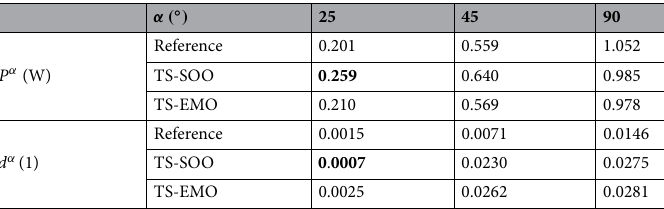
Table 1. Optimization results regarding color point deviation d α , and power P α of algorithm 1, and TS-EMO for α = 25 ◦ , and after local refinement. The designs featuring a multi-layer thin film are compared with the reference design, where only a color point optimization is conducted. In addition to the direct optimization objectives regarding ± 25 ◦ , we also report the color point deviations and energies for ± 45 ◦ and ± 90 ◦ observed for the respective optimized MTLFs. For ± 25 ◦ , highest power and lowest color point deviations are given in bold.